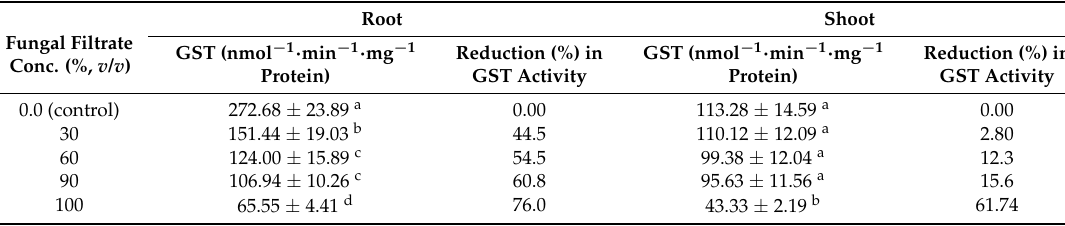
Table 2. Effect of different concentrations of P. vulpinum CM1 culture filtrate on the GST activity of root and shoot of 8-day-old maize seedlings. Calculated mean is for triplicate measurements from two independent experiments ±